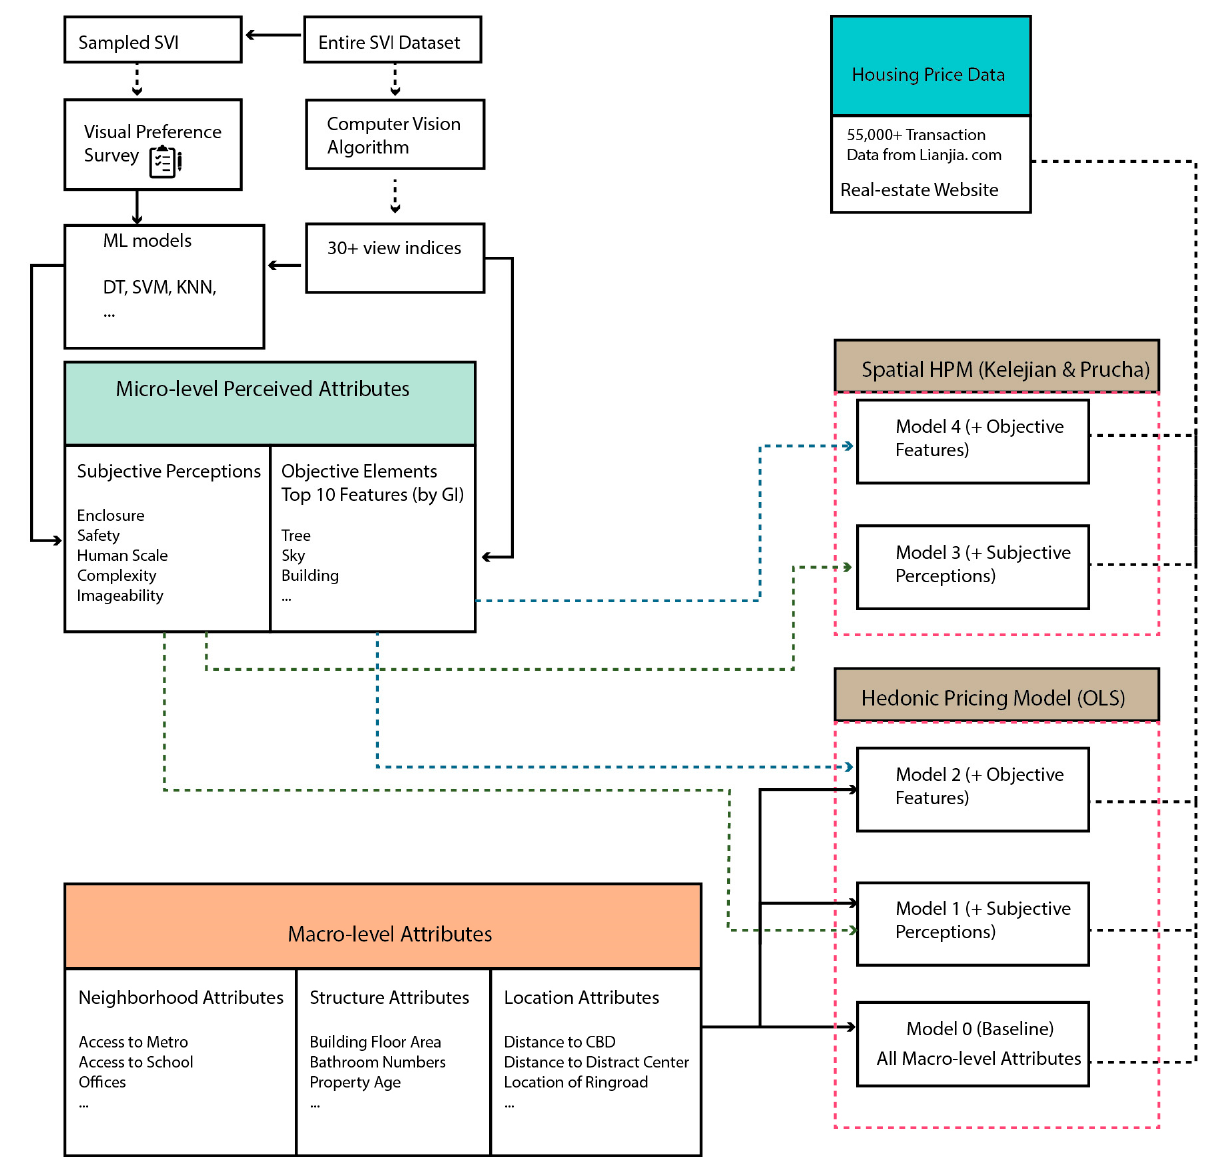
Figure 1. Methods and workflow.